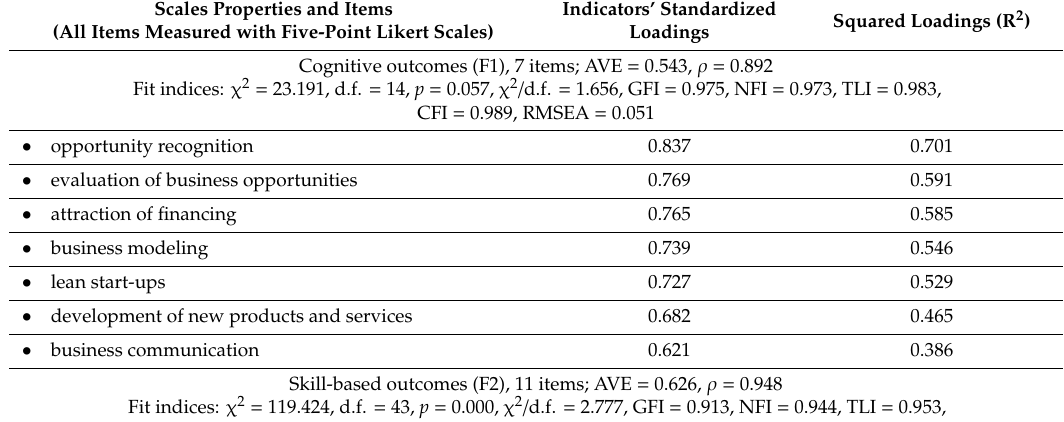
Table 2. Results of the confirmatory factor analysis (CFA) for the learning outcome constructs. Scales Properties and Items (All Items Measured with Five-Point Likert